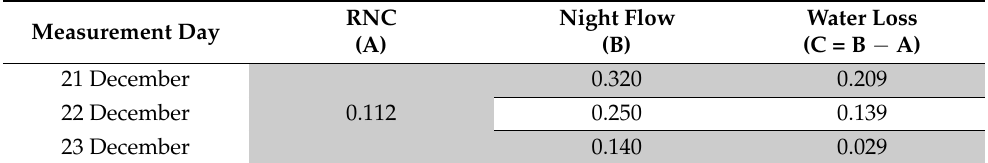
Table 3. Calculation of water losses for each measured day.